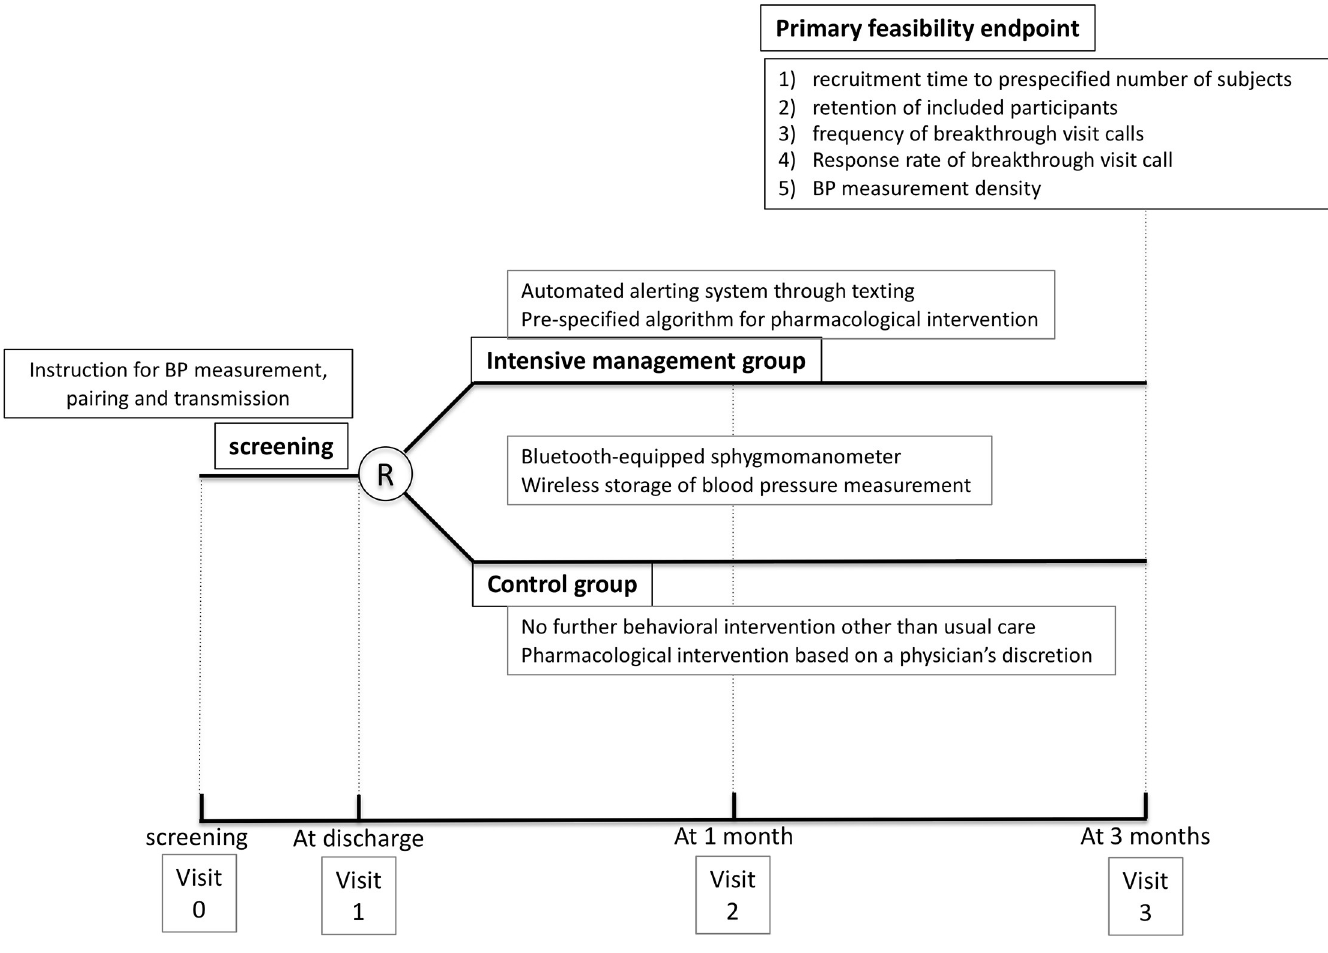
Fig 2. Overall trial